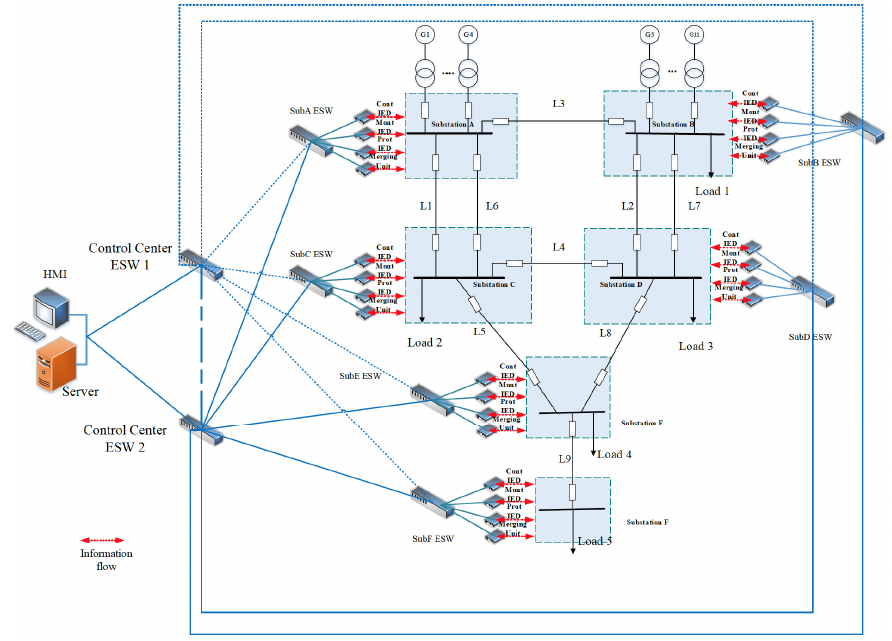
Figure 12. The CPES model of RBTS with the cyber layer of star-ring